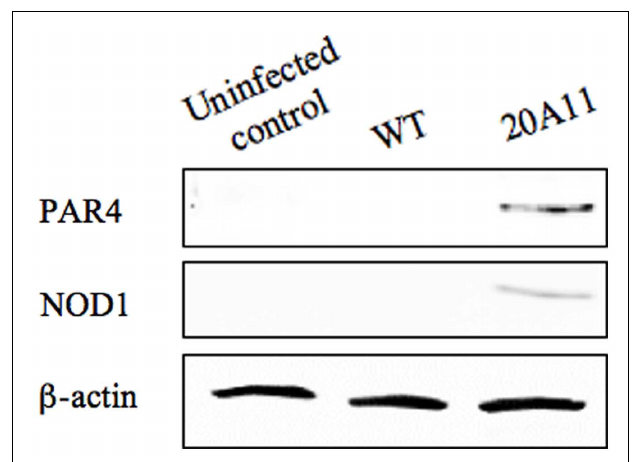
FIGURE 7 |Western blot analysis of PAR4 and NOD1 proteins. M. tuberculosis H37Rv or 20A11-infected U937 cell lysates were processed for immunoprecipitation and then subjected to protein analysis. Detectable levels of both proteins were observed just after 4days of